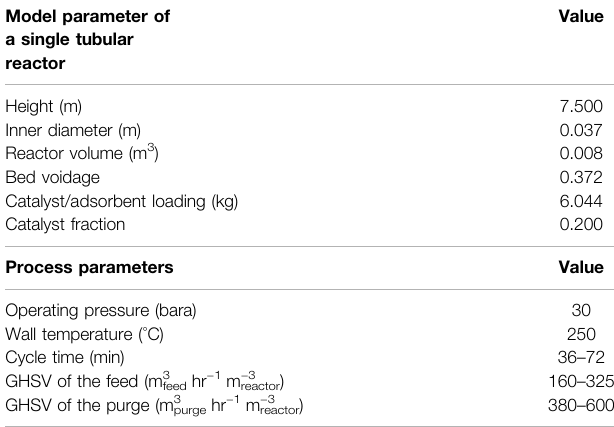
TABLE 2 | Parameters used in the SEDMES modeling